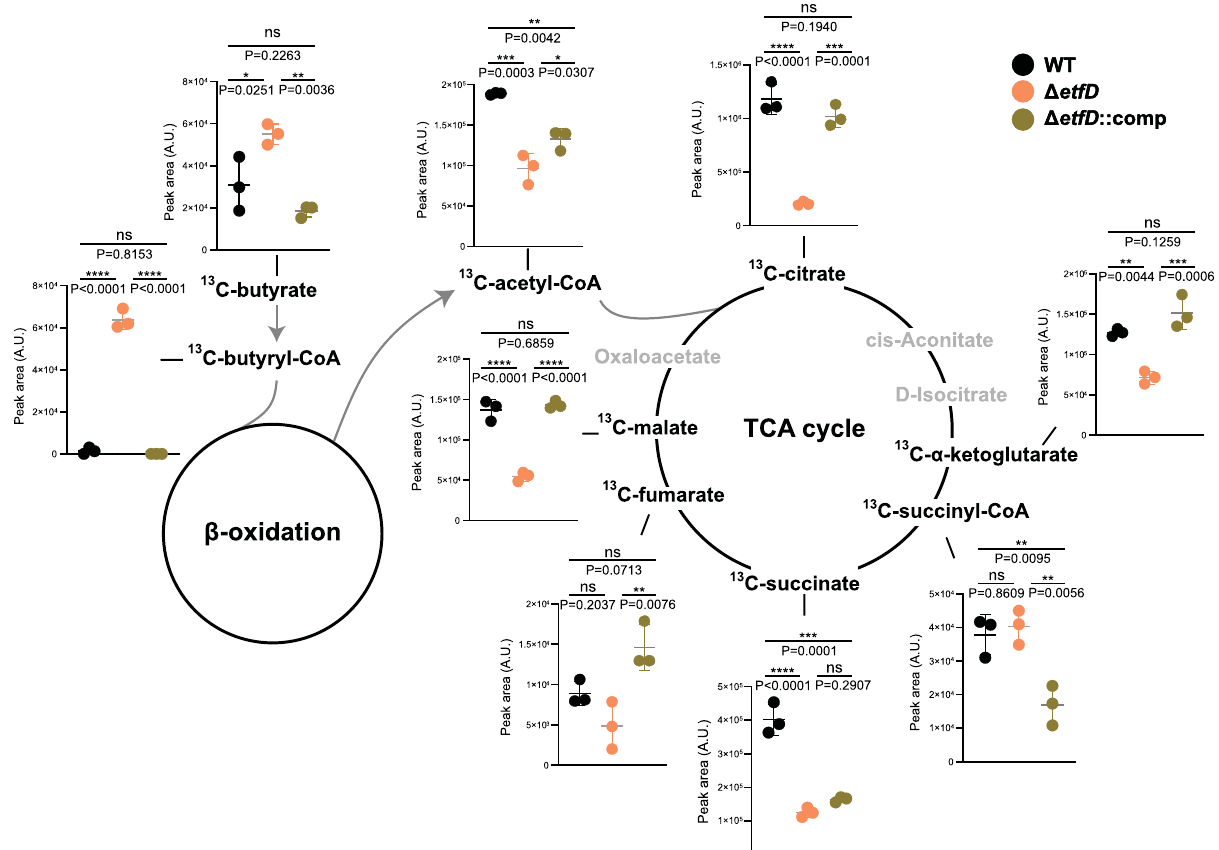
Fig. 4 Stable isotope tracing reveals a block in β -oxidation at the level of acyl-CoA dehydrogenases. Strains were grown on fi lters on top of solid medium permissible to Δ etfD growth for 7 days and then transferred to solid media with 13 C 4 -labelled butyric acid (2.5 mM) as single carbon source for 24 hrs. Levels of the indicated 13 C-labeled metabolites (total 13 C pool, except for 13 C 4 -butyrate) were quanti fi ed by LC-MS analysis. Data are averages of three replicates and are representative of two independent experiments. Error bars correspond to standard deviation. “ Comp ” stands for complemented. Statistical signi fi cance was assessed by one-way ANOVA followed by post hoc test (Tukey test; GraphPad Prism). * P < 0.05; ** P < 0.01; *** P < 0.001; **** P < 0.0001. ns not signi fi cant. # metabolites with no statistically signi fi cant difference between wild-type and Δ etfD in the second independent